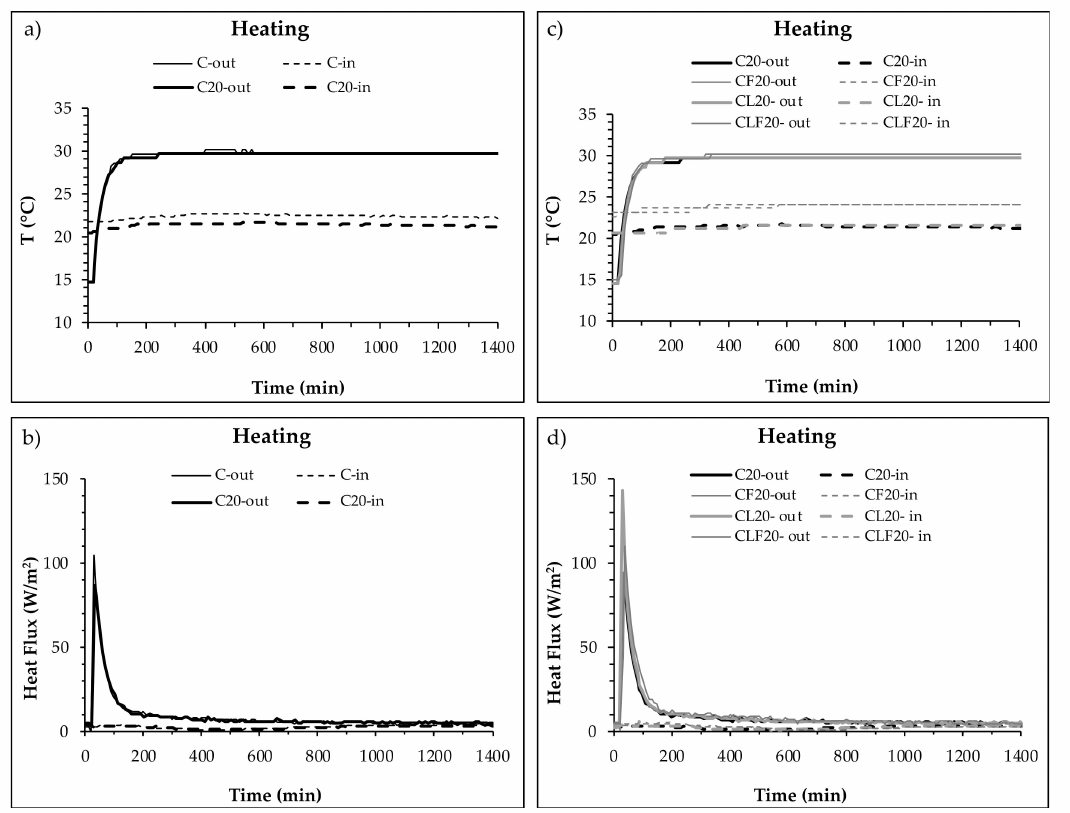
Figure 5. Temperature and heat flux monitored on the inner and outer sides of enclosures with a PCM cement-lime mortar layer during a heating cycle (from 15 ◦ C to 30 ◦ C). ( a ) Temperature of enclosures with and without PCM mortar layer (C and C 20 ). ( b ) Heat flux of enclosures with and without PCM mortar layer (C and C 20 ). ( c ) Temperature of enclosures with di ff erent types of PCM mortar (C 20 , CF 20 , CL 20 and